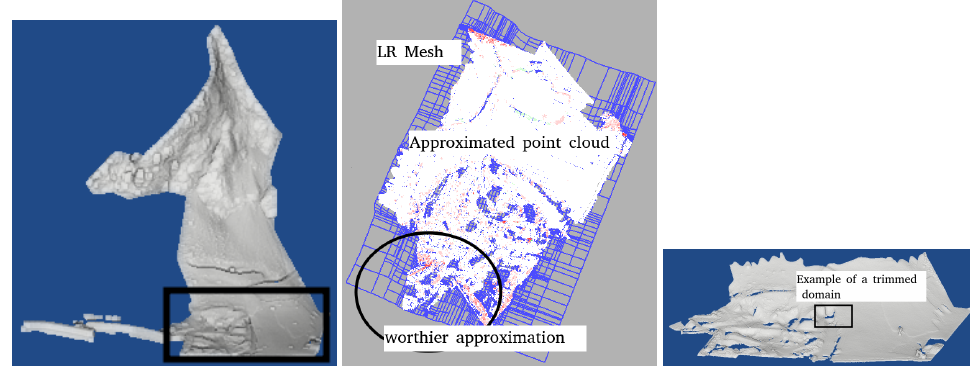
Figure 9. Left : Domain selected for surface approximation. Middle : points colored according to the distance to the approximated surface, together with the LR mesh. Right : The trimmed surface after seven